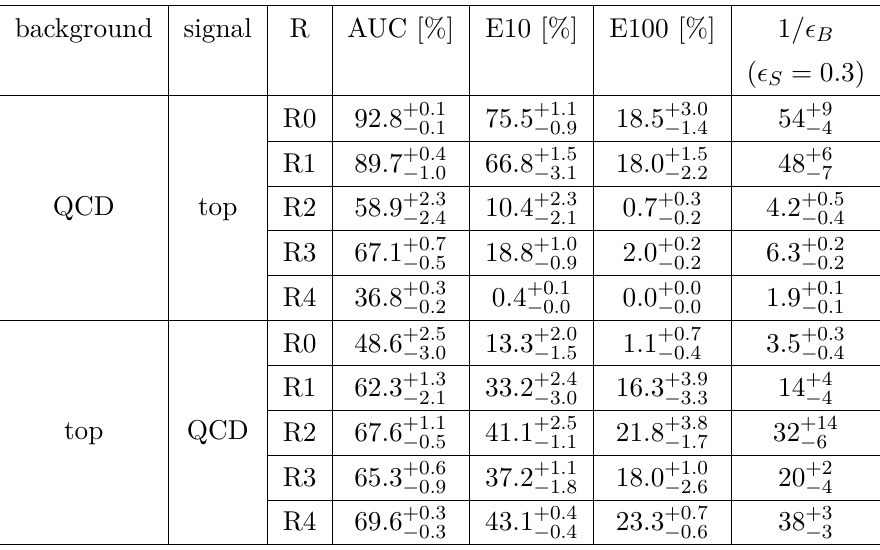
Table 2 . Performance measures for AE-based taggers for different remappings of the jet images trained using KMSE. Each value is an average of values for 4 autoencoders trained using the same hyperparameters but different initialization. The mentioned uncertainties denote the envelope of each